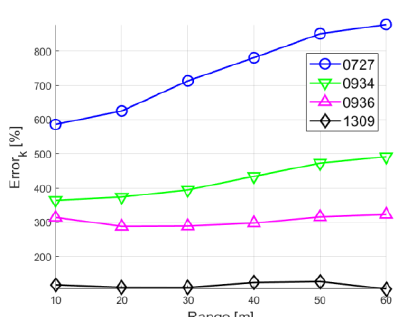
Fig. 3. Mean relative difference of Grasselli parameters ( 𝑒𝑟𝑟𝑜𝑟 𝑘 ) for noisy TLS surfaces of the four samples versus range